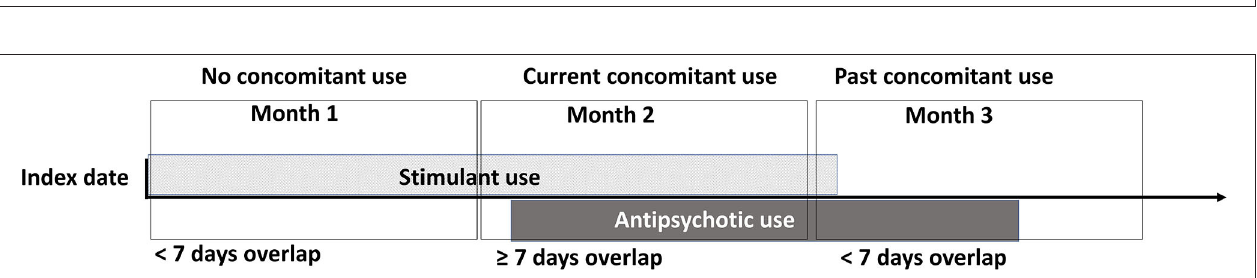
FIGURE 1 | Cohort identification of commercially-insured youth (5–17 years old) who were new users of stimulants, 2006–2015. a a Data source: IQVIA PharMetrics ® Plus, January 2006–December 2015. b Acute myocardial infarction, stroke, ischemic heart disease, heart failure, respiratory arrest, angina pectoris, cardiac dysrhythmias, transient cerebral ischemia, hypertensive disease, cardiovascular tachycardia, palpitations and syncope. c Aplastic anemia, cancer, cerebral palsy, congenital immune deficiencies, cystic fibrosis, dialysis/end stage renal disease, Down syndrome, other lethal chromosomal anomalies, fatal metabolic diseases, human immunodeficiency virus (HIV) infection, organ transplant, respiratory failure.